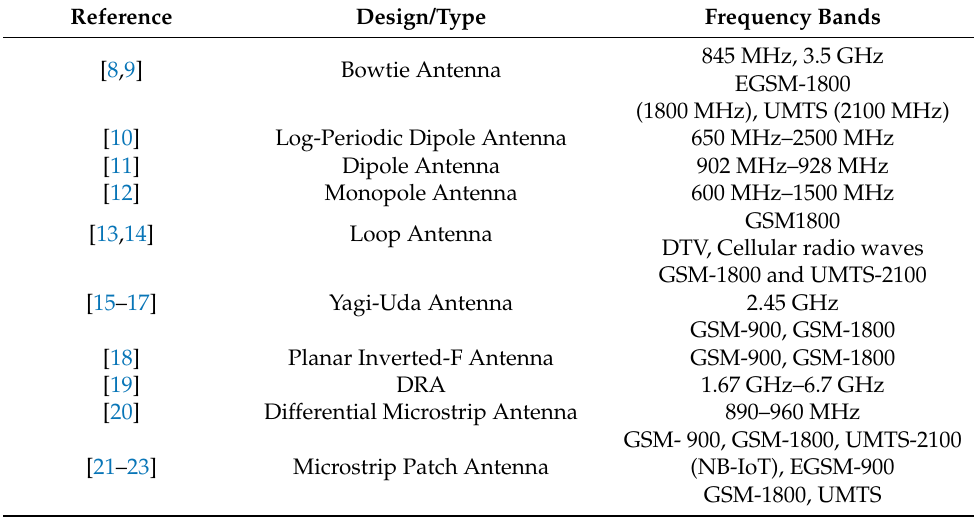
Table 1. Type of antennas that have been applied in RF energy harvesting